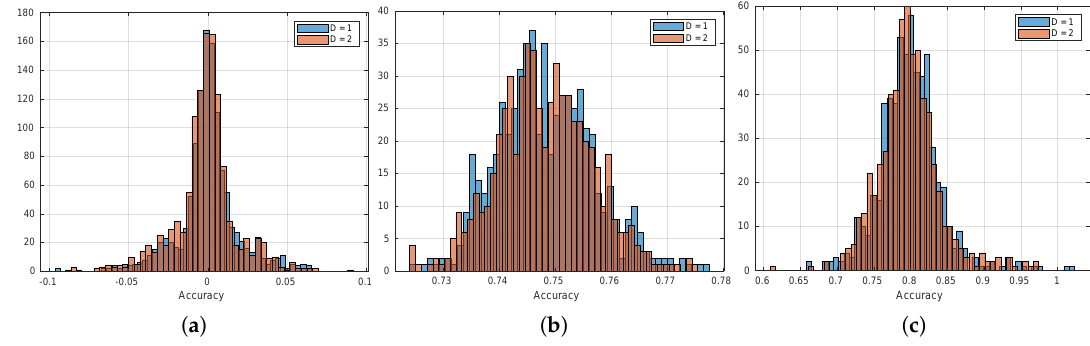
Figure A15. Histograms for the conclusions about the effect of factor D on the expected accuracy performance, represented for the two levels of such factor with additional restrictions on the population. ( a ) Factor C = 1. ( b ) Factor B = 1 and factor C = 2. ( c ) Factor B = 2 and factor C = 2.